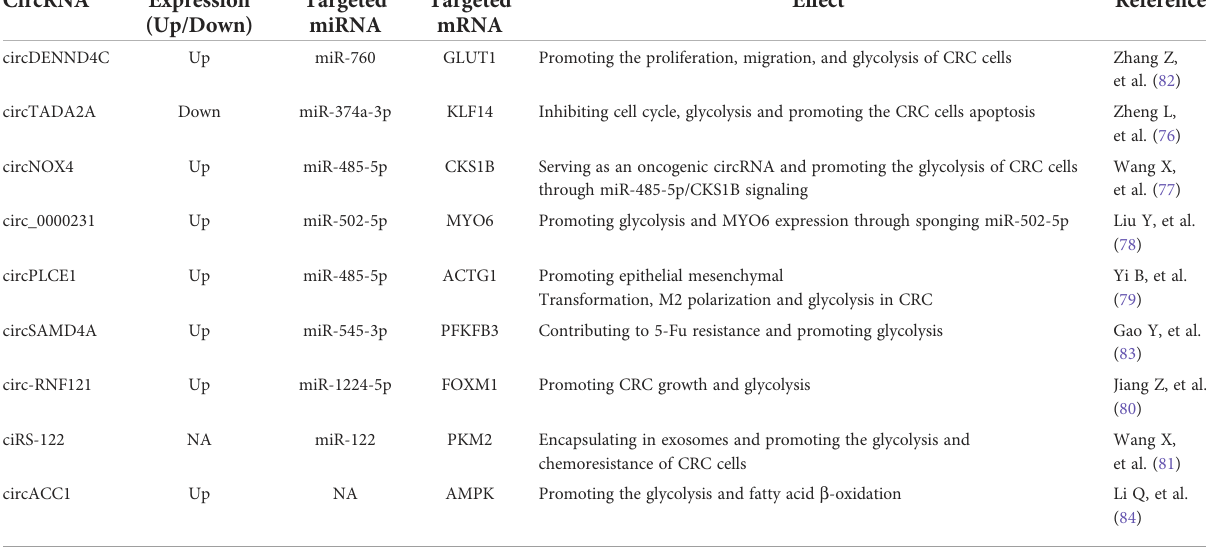
TABLE 3 CircRNAs involved in CRC glucose